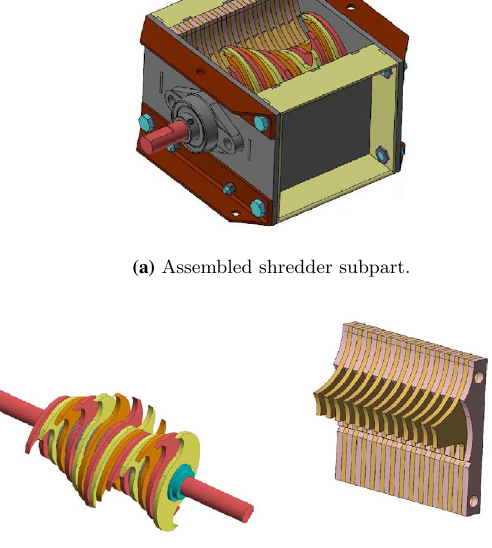
Fig. 5 Components of the shredder subpart